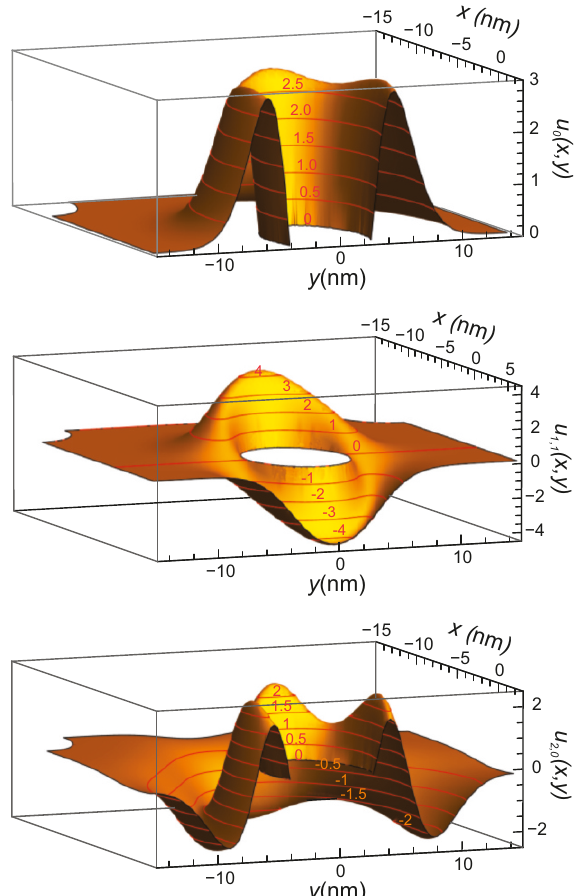
Figure 4. Cut views of 3 wave functions in the case of array model 1 ( R = 4 nm and a = 30 nm). Top : ground-state, no node; middle : first excited state ( m = 1) in the first shell of states ( n = 1 ) , a single radial node along the Oy axis; bottom : first state in the second shell of states ( n = 2, m = 0), two radial antinodes. In red, curves of wave-function equal values. See text for more detail, including definition of wave-function